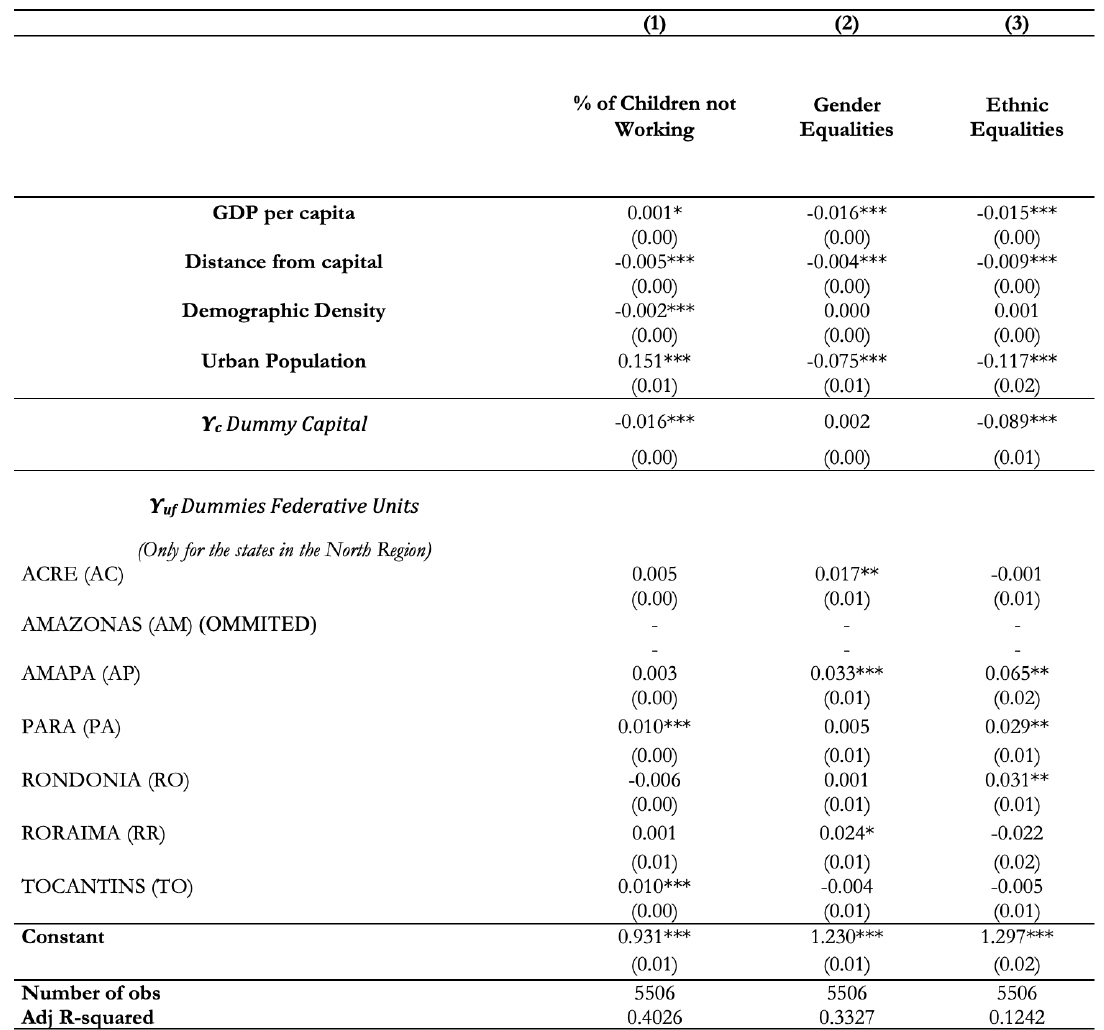
Table 2: Labor Standards Regressions MODEL A